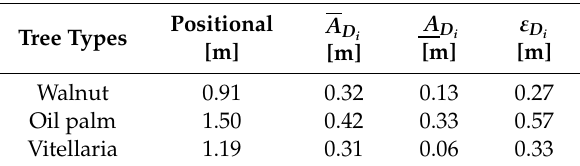
Table 2. Positional inaccuracy, overestimation, and underestimation metrics based upon the modified tree size measurement at s 0 using model f 3 ( s ).